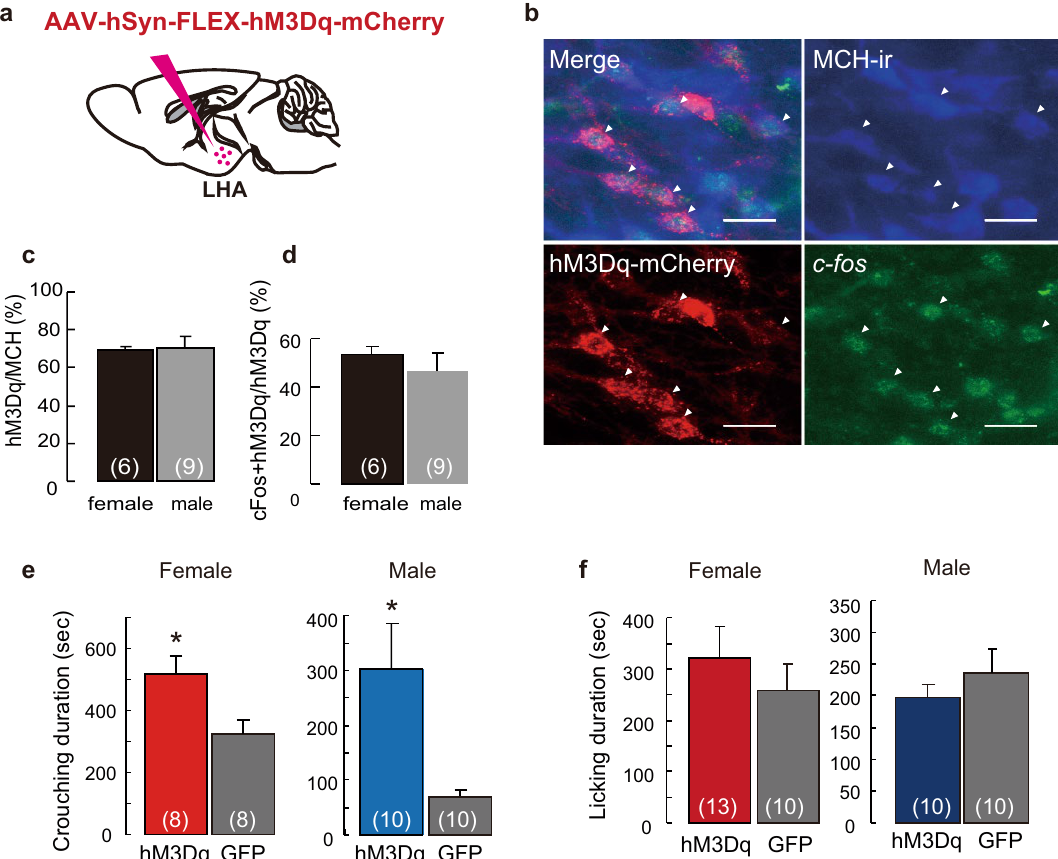
Figure 3. Cre-dependent activation of MCH-producing neurons effects of parenting and transduction efficiency of hM3Dq-mCherry AAV vector. ( a ) Illustration of sagittal brain sections injected with AAV-hSyn- FLEX-hM3Dq-mCherry into the LHA. ( b ) Simultaneous visualisation of Cre-MCH-dependent expression of hM3Dq-mCherry and c-fos positive-MCH-ir cells (arrowheads). Scale bars, 20 μm. ( c ) Quantitative analysis of MCH neurons injected by hM3Dq-mCherry AAV vector in MCH-Cre female and male mice. Transduction efficiencies were calculated in both sexes by injecting hM3Dq-mCherry AAV vector in MCH neurons. ( d ) The percentage of c-fos expression in MCH neurons injected with the AAV-hM3Dq-mCherry in MCH-Cre mice. ( e ) Duration of crouching and ( f ) licking from the pup presentation, 90 min after CNO injections. Mean ± S.E.M. t-test, * p <